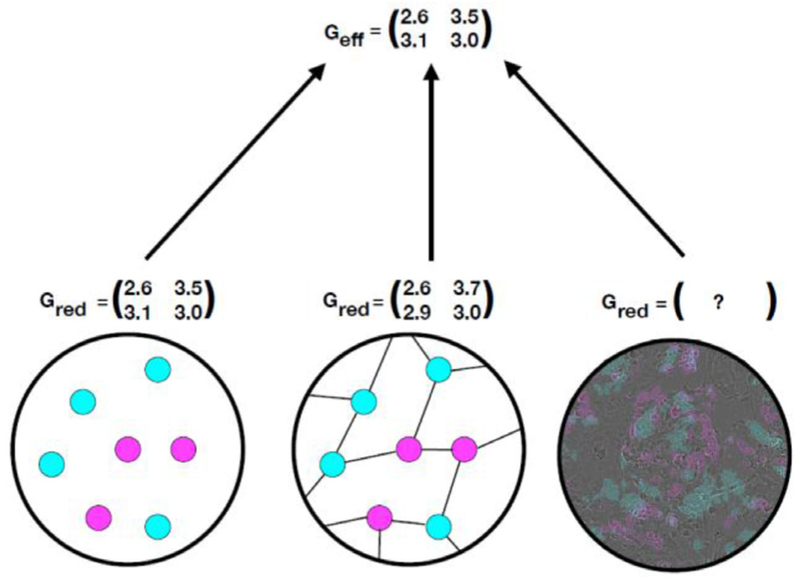
The same effective game [95] implemented by three different population structures and reductive games; from left to right: inviscid population, random 3-regular graph, experimental in vitro non-small-cell lung cancer [91].